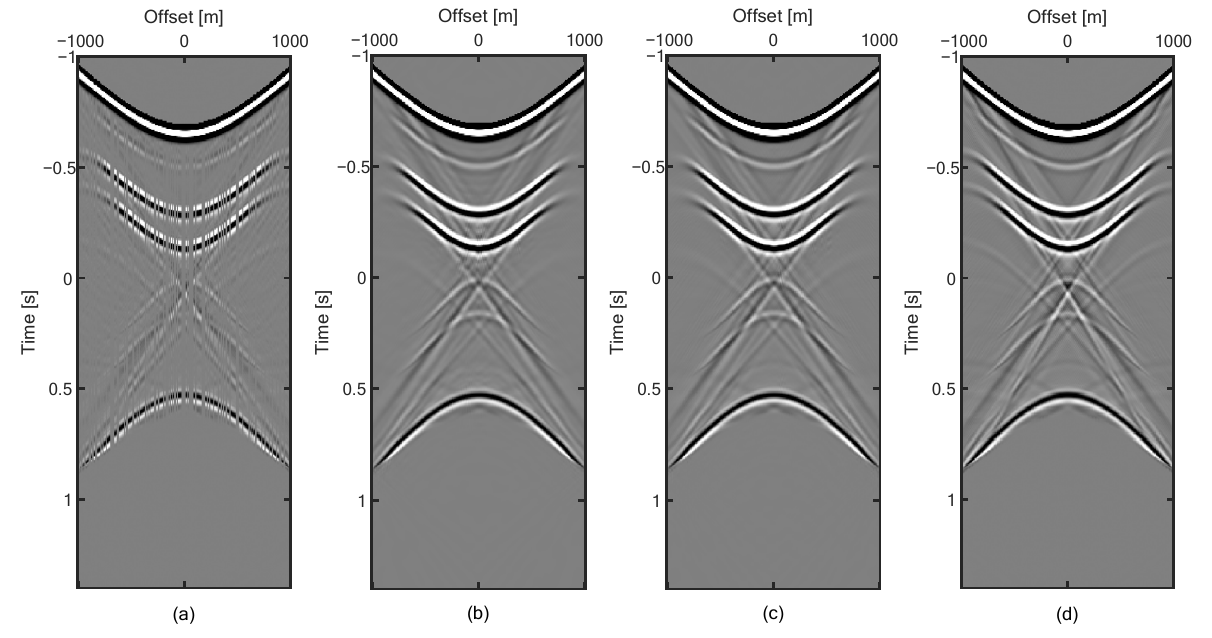
Figure 10. Comparison of the focusing functions. ( a ) is obtained using the standard Marchenko method with irregular sampling; ( b ) is obtained using sparse reconstruction with SPGL1 solver; ( c ) is obtained using sparse reconstruction with FISTA solver; and ( d ) is the reference focusing function.